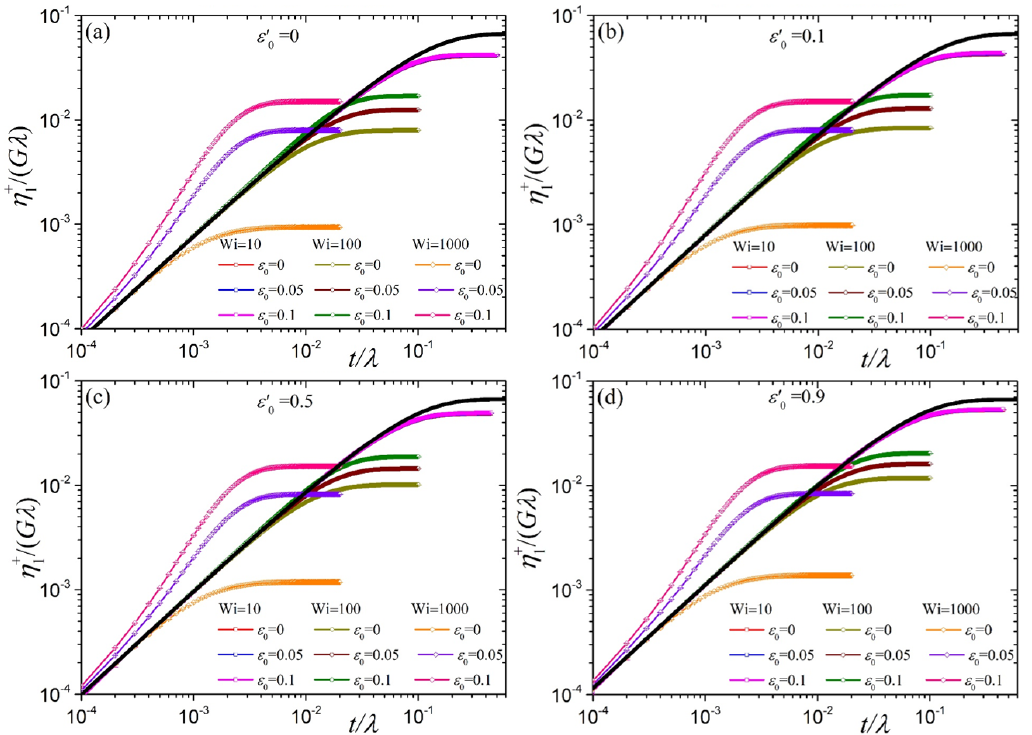
( ˙ (cid:101) , t ) / G λ for the model with variable ε as a function of time for N = 100 and Figure 8. Predictions for η + 1 various values of the parameter ε 0 and the dimensionless elongation rate Wi for ( a ) ε (cid:48) = 0.5, and ( d ) ε (cid:48) = 0.9. The solid black lines represent the linear viscoelastic results, Equation (28), ( c ) ε (cid:48) 0 0 their initial slopes are given by the right hand side of this equation with ε (cid:48) = ε (cid:48) model with constant ε the transient viscosities do not vanish in the limit t / λ → 0 (see Supplementary Section B).